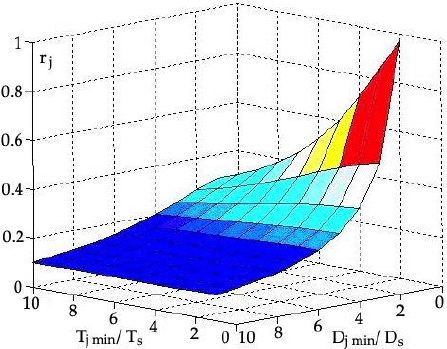
Figure 9. Collision risk dependence of relative distance and time values of passing objects.